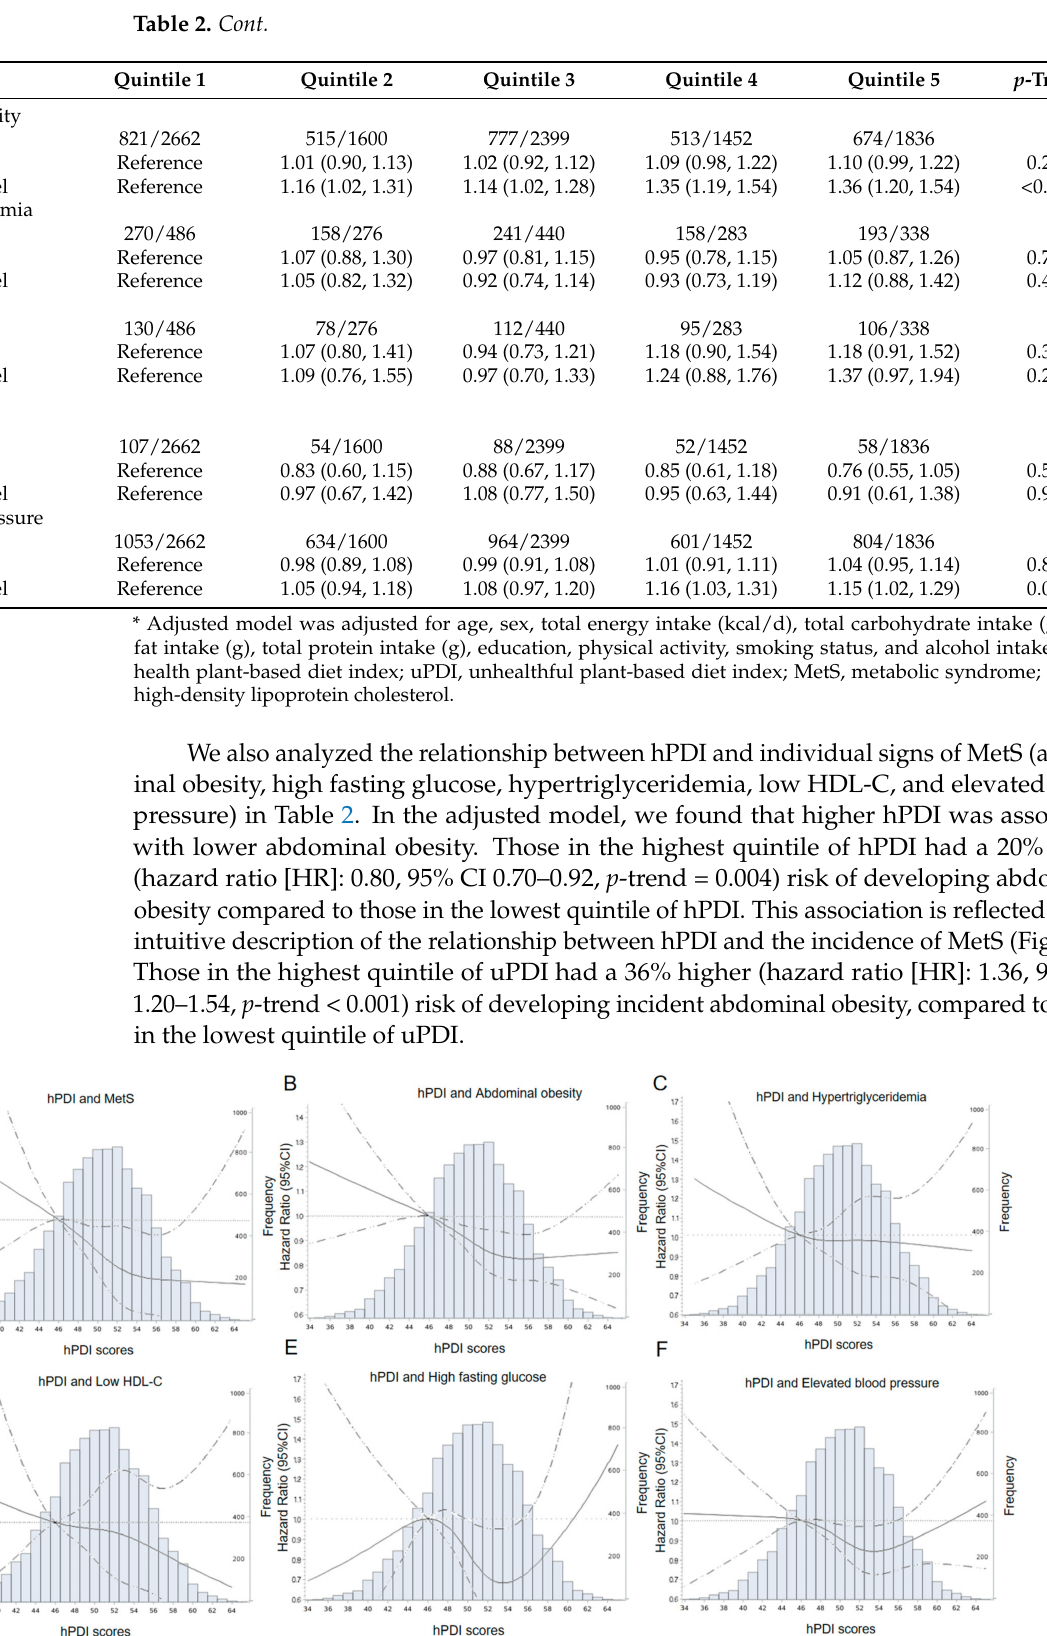
Figure 2. Adjusted hazard ratios and 95% confidence intervals for incident MetS ( A ), abdominal obesity ( B ), hypertriglyceridemia ( C ), low HDL-C ( D ), high fasting glucose ( E ), and elevated